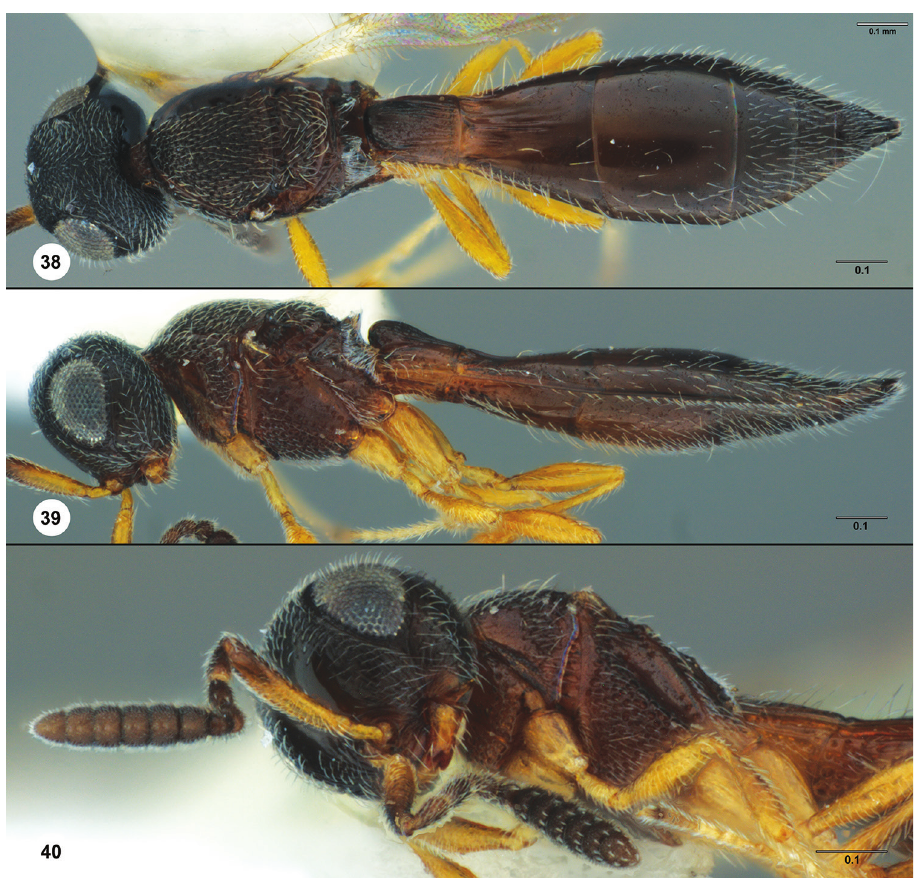
Figures 38–40. Probaryconus cauverycus , female (USNMENT01223894). 38 head, mesosoma, meta- soma, dorsal view 39 head, mesosoma, metasoma, lateral view 40 head, mesosoma, ventrolateral view. Scale bars in